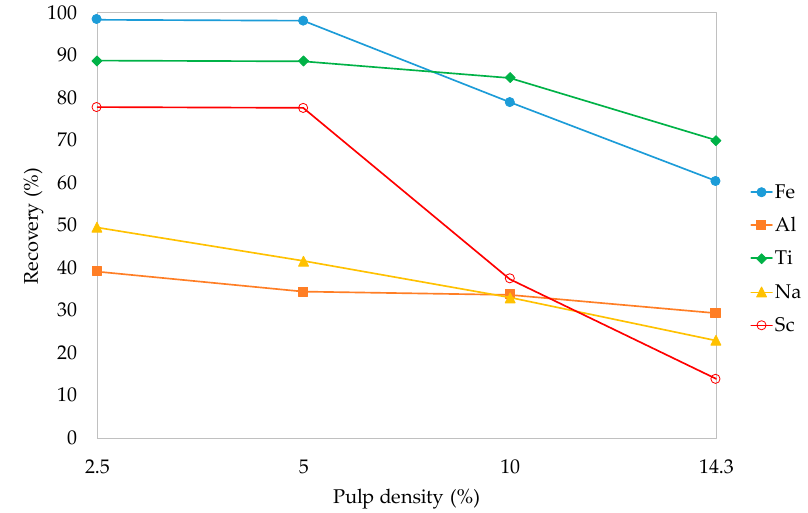
Figure 7. Study on the system behavior for metals dissolution by changing pulp density when leaching BR with [Emim][HSO 4 ] at 12 h, 200 rpm, 200 ◦